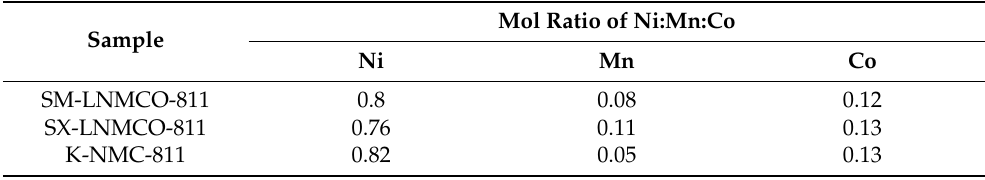
Table 6. Comparison of Ni:Mn:Co elements contained in precursors K-NMC-811, SM-LNMCO-811, and